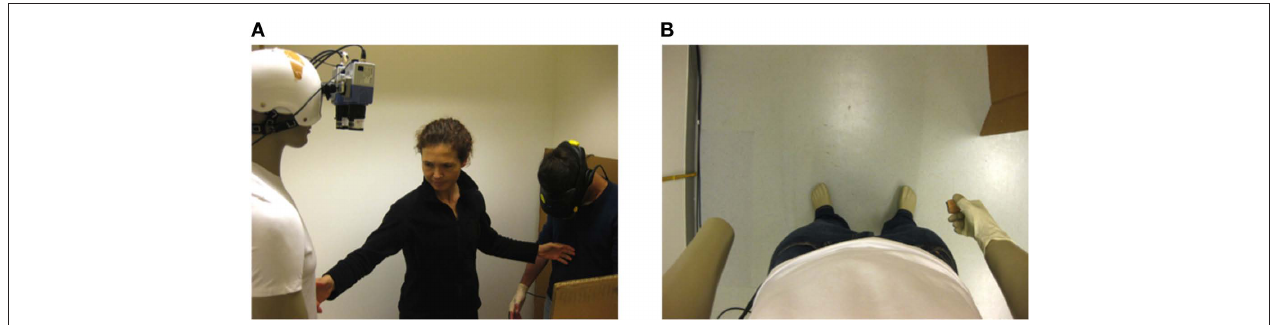
Figure 1 | experimental setup. (A) For the induction of the full-body illusion synchronous strokes were applied to the participants and the mannequin, while the participants were viewing the mannequin’s body through a set of HMDs. (B) View of the mannequin’s body, which was missing its left hand, from the